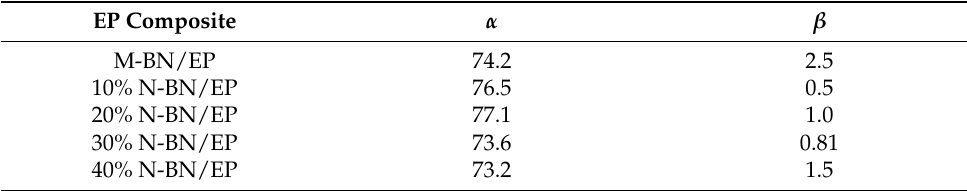
Figure 4. Breakdown strength data of BN/EP composite. Table 1. Breakdown strength data of EP composite.